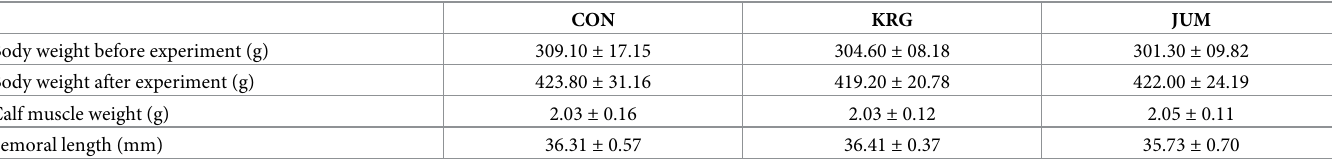
Table 1. Body weight, hindlimb muscle weight, and femoral length in experimental rats.